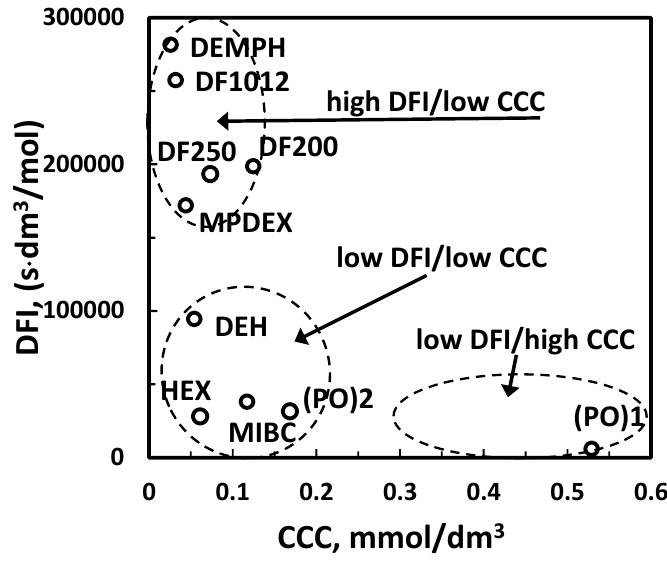
Figure 9. Map-type relation between DFI and CCC and two-numerical value classification of frothers in the frother/aqueous solutions/gas system (data of [16]).